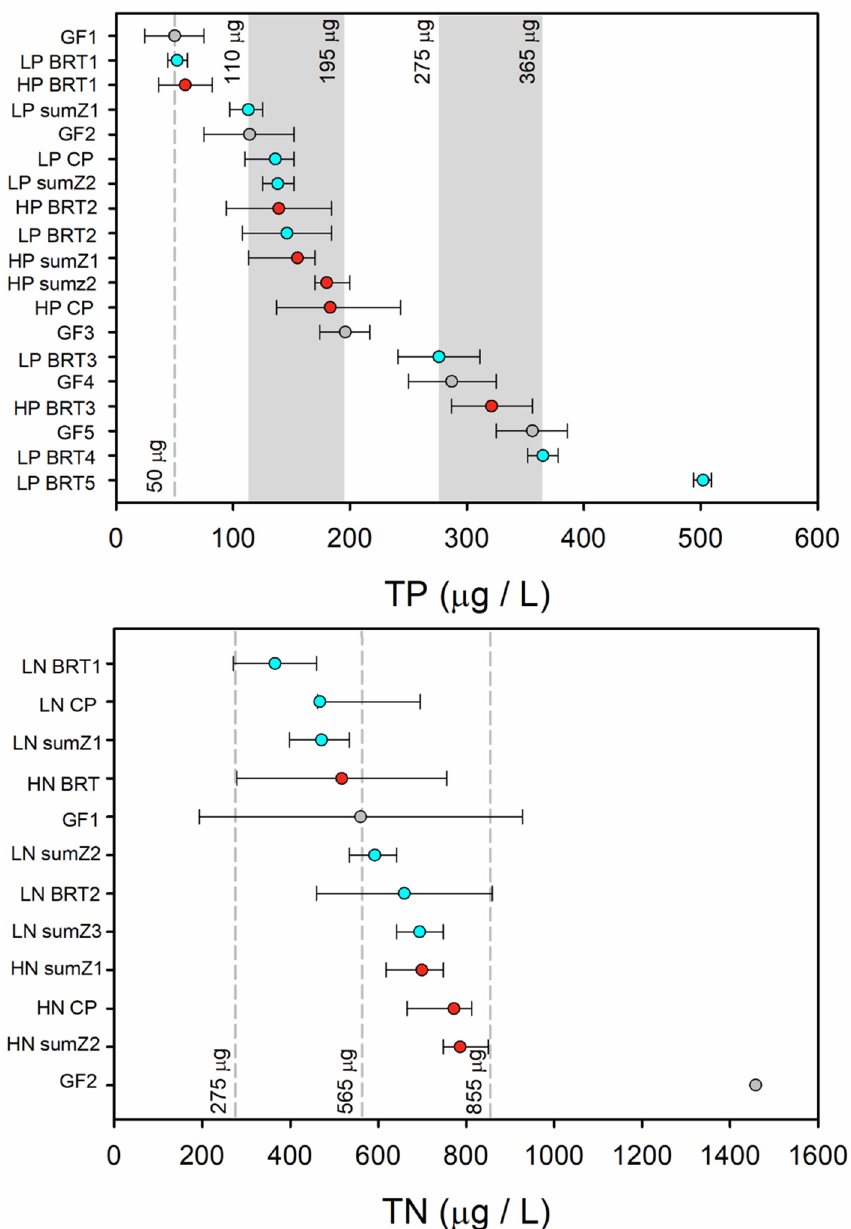
Figure 6. Summary of change points for TP and TN across the indicator analyses. Circles denote the mid-response value with horizontal bars show 5th to 95th quantiles for TITAN results and the beginning and end of responses for boosted regression trees and gradient forest results. Light blue circles are for low nutrient taxa, red circles are for high nutrient taxa, and gray circles are assemblage changes from gradient forest analyses. Bacterial responses occurred at multiple values along the TP or TN gradients and those are noted as sumZ1, sumZ2, BRT1, BRT2, etc. Vertical dashed lines and gray bars mark concentrations on the TP or TN gradients with substantial changes in bacterial assemblage. (LP = low phosphorus, LN = low nitrogen, HP = high phosphorus, HN = high nitrogen, CP = change point, BRT = boosted regression tree analysis, GF = gradient forest analysis). GF2 has no horizontal bars because it only briefly exceeded the density-of-splits to density-of-data ratio of 1.